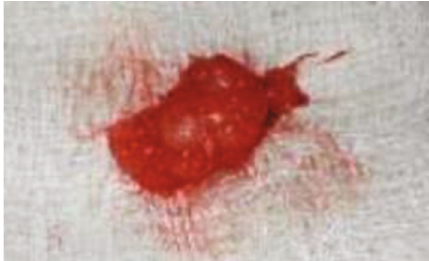
Figure 4: Gross excised specimen was suggestive of a fi rm nodular